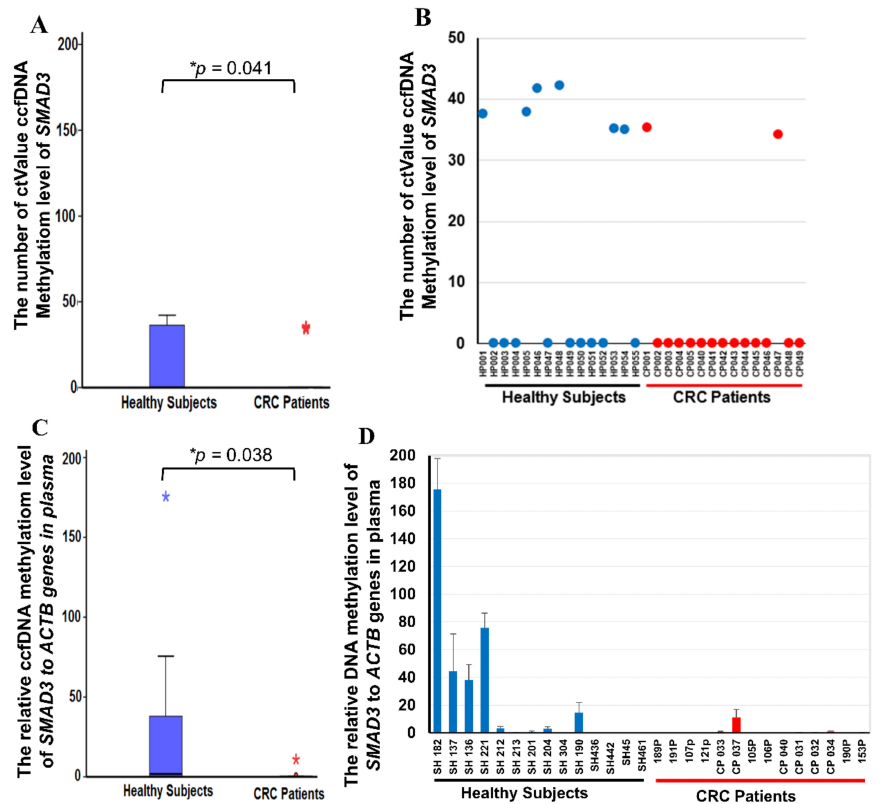
Figure 4. Circulating cell-free DNA methylation levels in Taiwanese patients with colorectal cancer (CRC). ( A ) The box plot of SMAD3 methylation levels in 200 µ L plasma. ( B ) Circulating methylated SMAD3 levels determined by using quantitative methylation-specific polymerase chain reaction in 15 healthy subjects and 15 patients with CRC in 200 µ L plasma extracted through a manual process. ( C ) The box plot of SMAD3 methylation levels in 1 mL plasma. ( D ) Circulating methylated SMAD3 levels in 14 healthy subjects and 14 CRC patients in 1 mL plasma. Experiments were performed with three technical replicates. * p ≤ 0.05. A t test was used to calculate group di ff